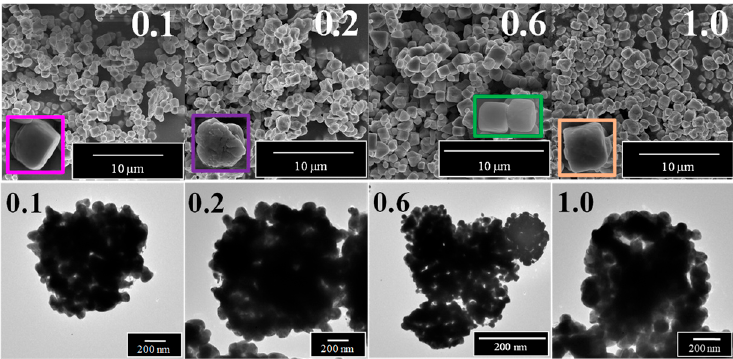
Figure 5. Effect of PVP amount on the morphology of AgCl (SEM micrographs—top row; transmission electron microscopy (TEM) micrographs—bottom row).